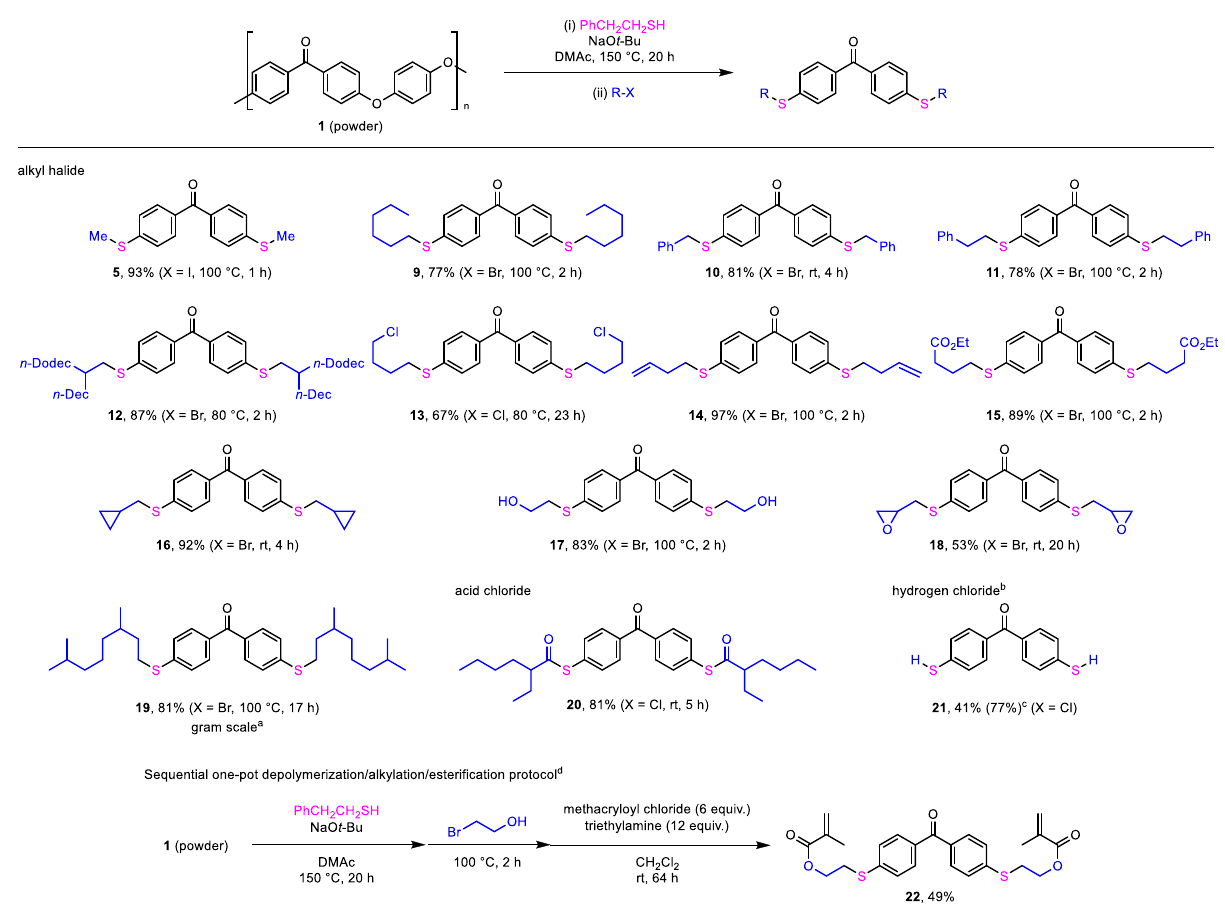
Fig. 3 Scope of electrophiles after PEEK depolymerization. Reaction conditions: (i) PEEK powder (0.3 mmol relative to the molecular weight of the monomer), PhCH 2 CH 2 SH (1.2 mmol), NaO t- Bu (0.9 mmol), DMAc (0.6 mL), 150 °C, 20 – 22 h. (ii) Electrophile (0.9 mmol) under conditions in parentheses. For each compound, the isolated yield is given in percentage. a PEEK powder (4.0 mmol relative to the molecular weight of the monomer), PhCH 2 CH 2 SH (16 mmol), NaO t -Bu (12 mmol), DMAc (8 mL), 150 °C, 22 h. (ii) 1-bromo-3,7-dimethyloctane (12 mmol), 100 °C, 2 h. b aq. HCl (2 M, 2.0 mL). c NMR yield. d After step (ii), methacryloyl chloride (1.8 mmol), triethylamine (3.6 mmol), and dichloromethane (0.6 mL) was added to the mixture, which was stirred at room temperature for 64